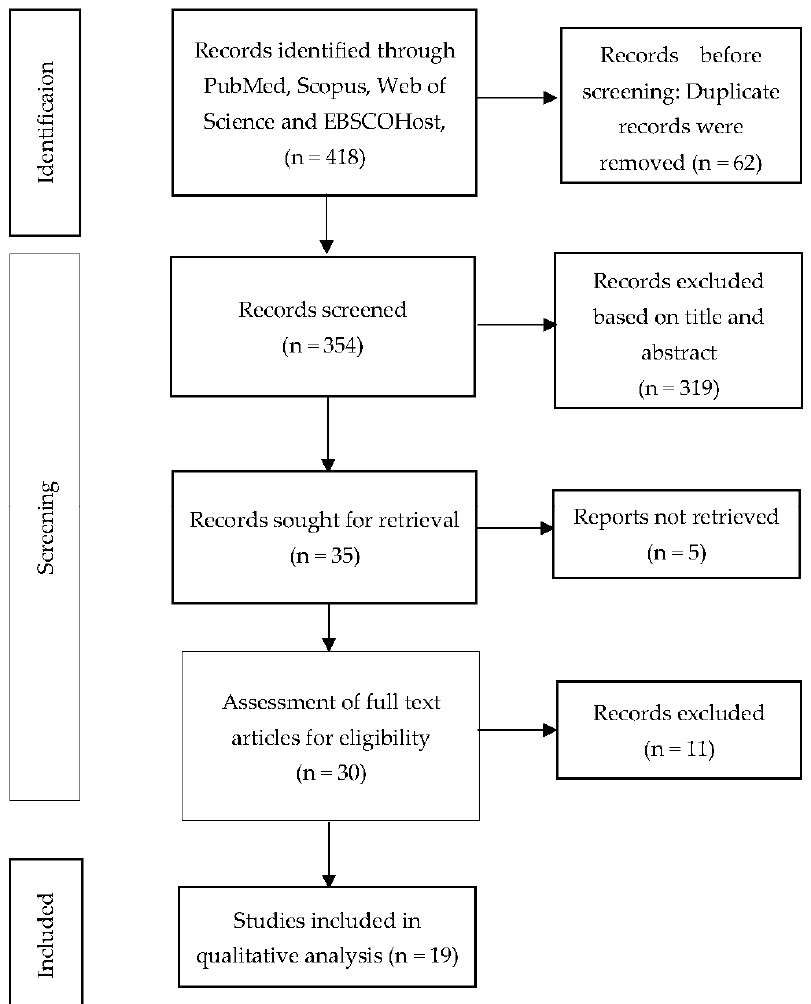
Figure 1. PRISMA flow diagram.